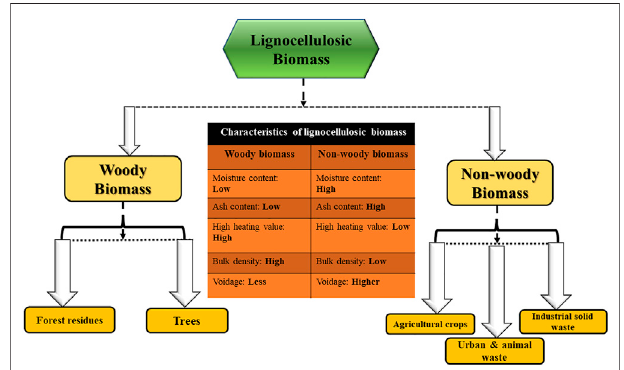
FIGURE 1 | Types of lignocellulosic biomass and their